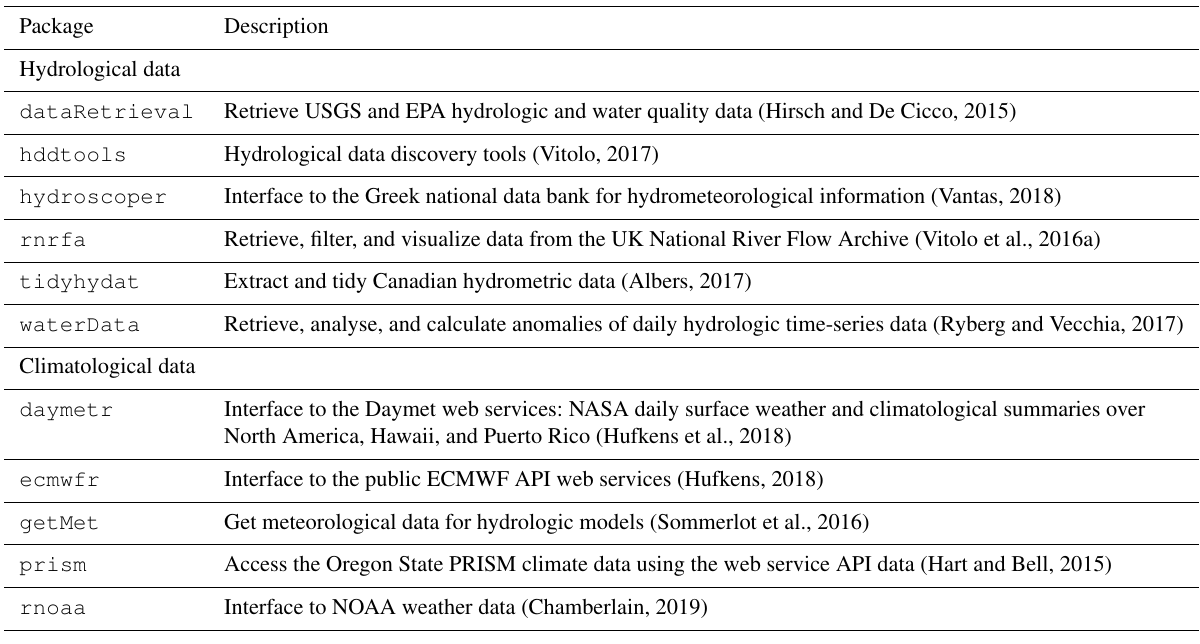
Table 1. Examples of packages for hydrological and/or meteorological data retrieval. See the Hydrology Task View for latest additions